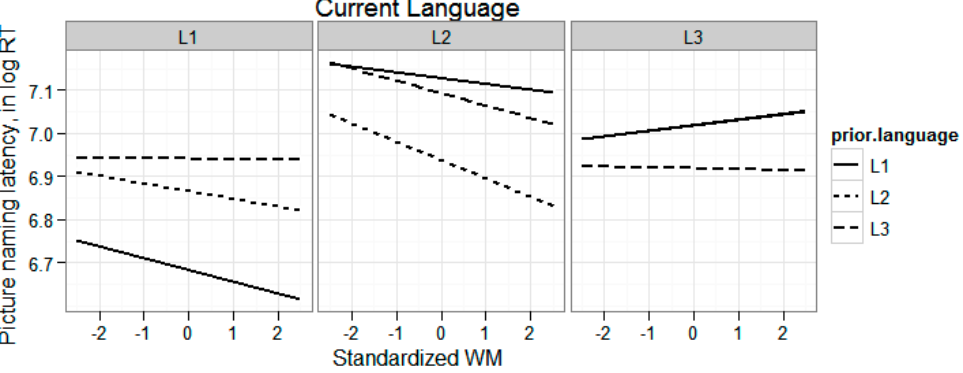
Figure 5. Relationship between working memory and picture naming latencies (in log RT) within each current language and prior language condition. A larger standardized working memory (WM) score indicates better working memory updating abilities.